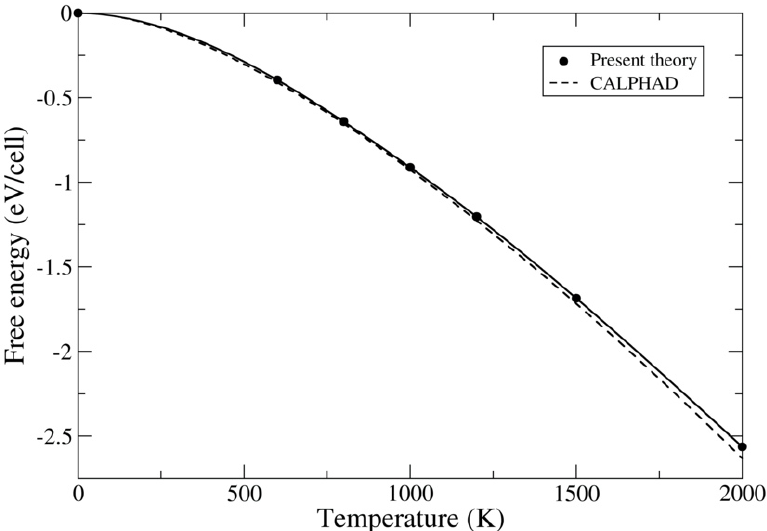
Figure 9. Free energy for PuC from present theory together with results from our CALPHAD calculation (dashed line). Solid symbols show our present theory, and the solid line is guide for the eye only.